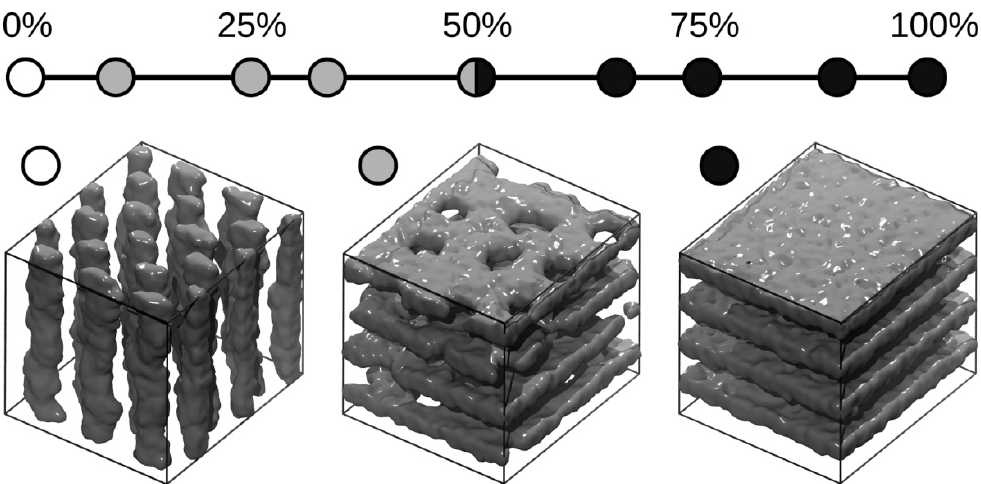
Figure 3. Morphology of the PB microphase as a function of hPB fraction. The PS and PMMA blocks form lamellae in all cases, and they have been omitted for clarity. The symbols indicate results at φ = 0%, 10%, 25%, 33%, 50%, 66%, 75%, 90%, and 100%. The snapshots show typical configurations of cylinder, perforated lamella, and lamella structures at φ = 0%, 33%, and 90%, respectively.